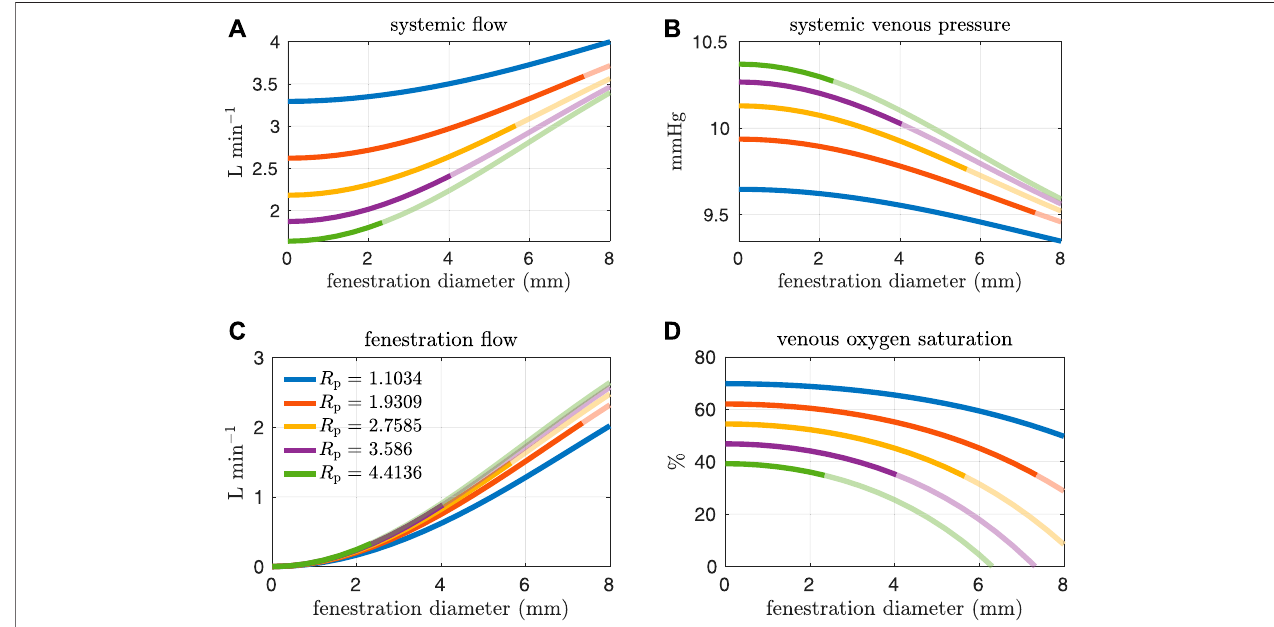
FIGURE 6 | Results corresponding to oxygen consumption equal to − 0.2 L min − 1 . Pulmonary resistance values R p larger than our baseline value are considered. Mean values for different hemodynamic and oxygen transport variables are plotted as functions of the fenestration diameter. (A) systemic fl ow, (B) systemic venous pressure, (C) fenestration fl ow, (D) venous oxygen